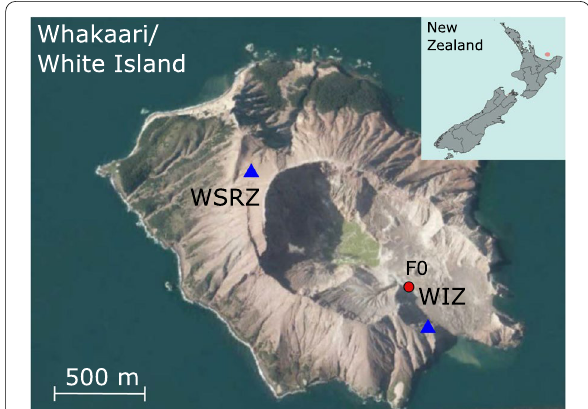
Fig. 1 Whakarari/White Island volcano and seismic stations (blue triangles) and fumarole F0 (red circle) locations ( source: Google Earth). Inset on the upper left corner shows the location of the volcano (red circle) in New